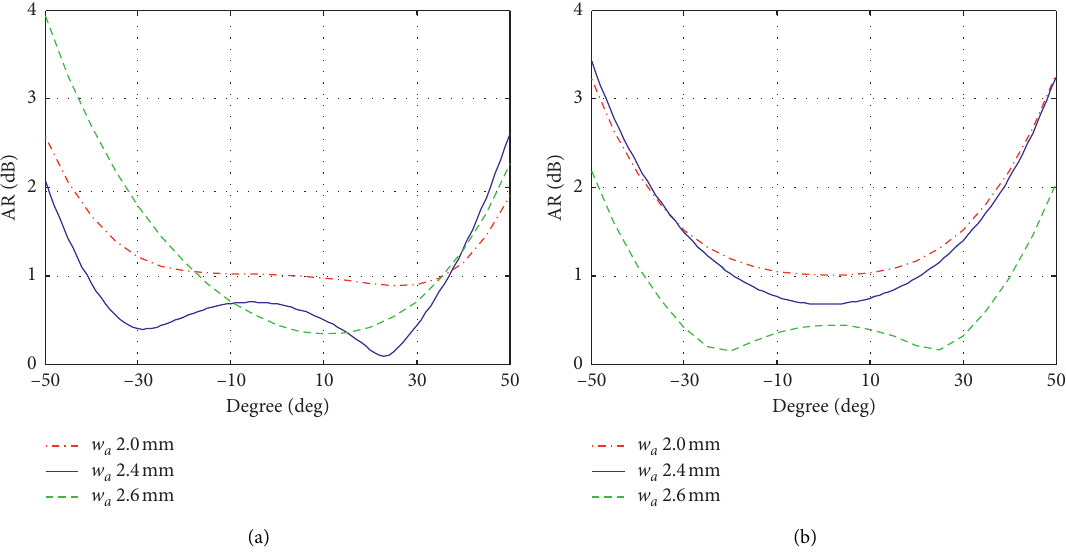
Figure 9: The simulated AR with different w